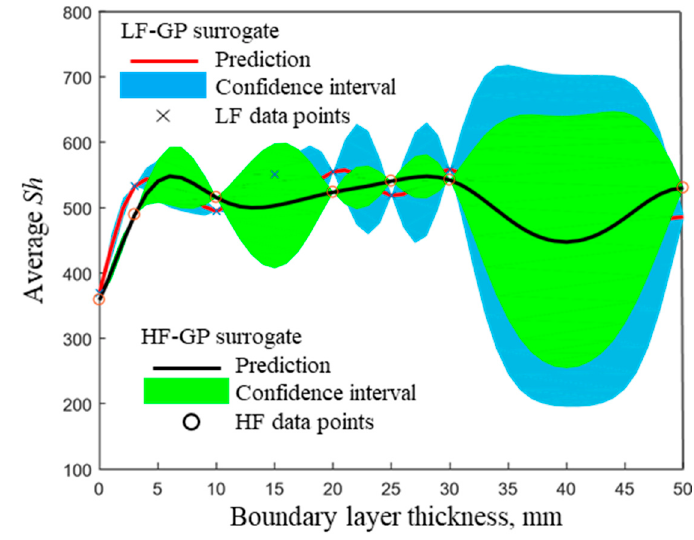
Figure 7. 1D projection of LF-GP and HF-GP surrogate for a fixed Re of